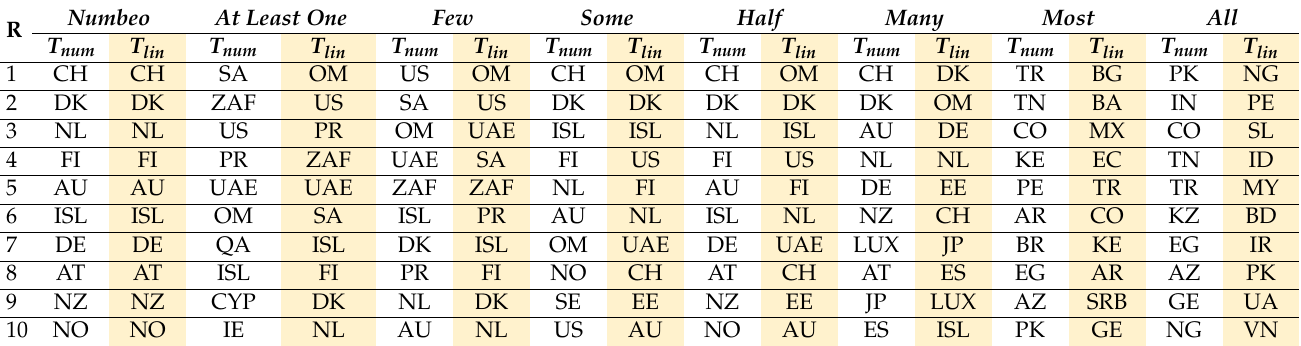
Table 10. Re-ranked QOLI of top 10 countries (number versus. 2-tuple